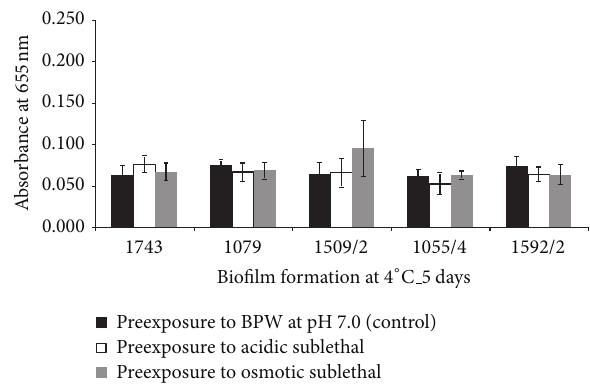
Figure 4: Values of absorbance at 655 nm obtained for five L. monocytogenes isolates after being exposed to acidic and osmotic sublethal stresses and tested for biofilm formation at 4 ∘ C during 5